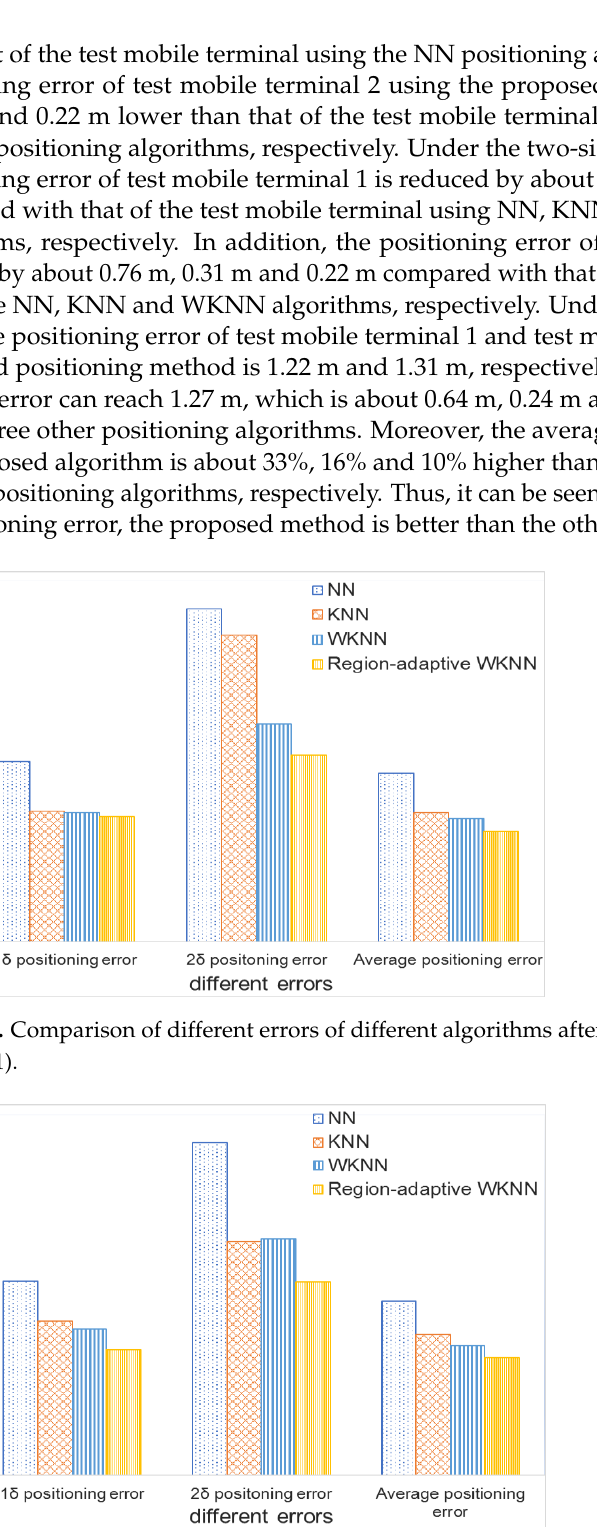
Figure 18. Comparison of different errors of different algorithms after calibration. (Testing mobile terminal 2).